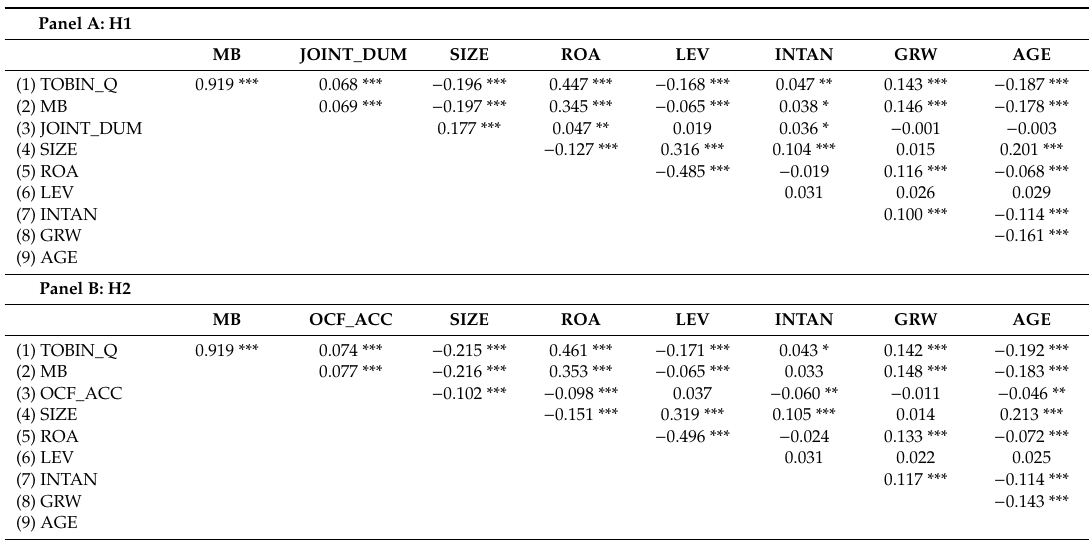
Table 4. Pearson